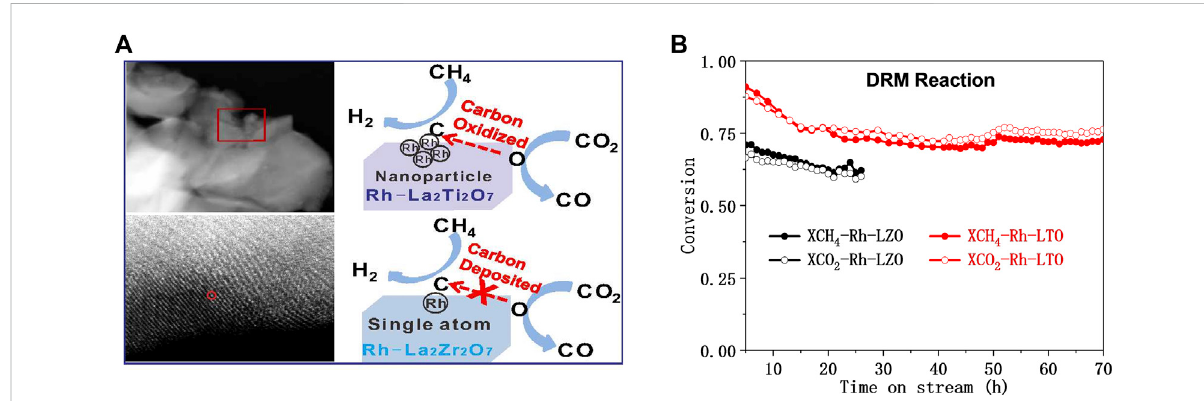
FIGURE 9 Schematicdiagramof theDRM reaction (A) and thelifetime teston Rhsubstituted-La 2 B 2 O 7 (B =Zr orTi) (B) . Reproduced from Wu etal. (2018); Copyright © 2018 (American Chemical